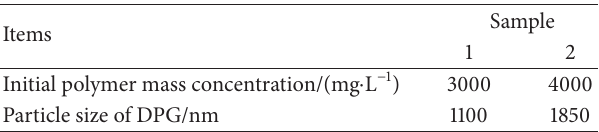
Table 1: Relationship between the particle size of DPG and the initial polymer mass